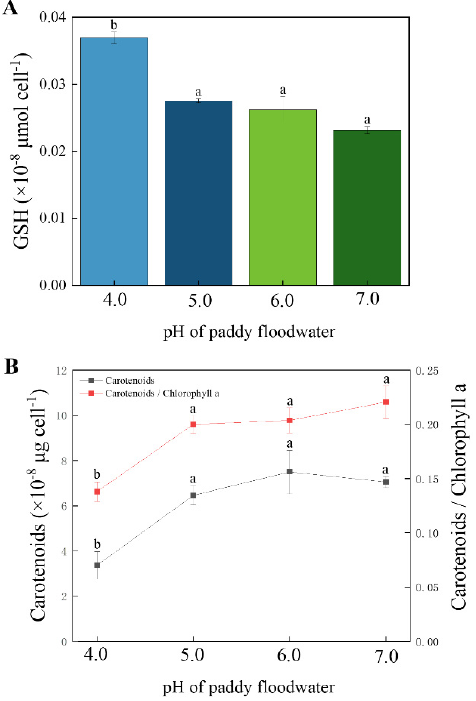
Figure 7. Effects of paddy floodwater acidification on levels of non-enzymatic antioxidants re- duced GSH ( A ) and carotenoids ( B ) in the cells of Aliinostoc sp. YYLX235. Different letters indicate statistically significant at p < 0.05 (one-way ANOVA, LSD).